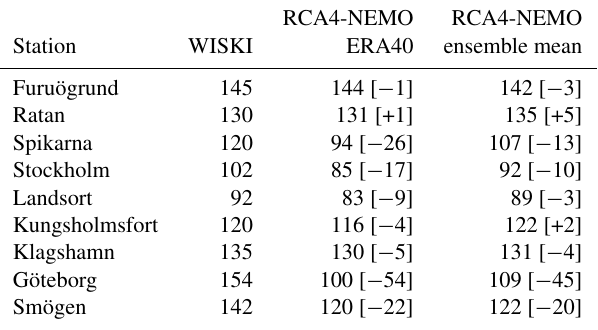
Table 9. Extreme sea levels (cm) with 100-year return period (1961 to 2005) for selected stations along the Swedish coast (cf. Fig. 4). The values in brackets indicate model biases relative to the obser- vational estimates. Note that the results in this table are from model runs that do not use a storm surge